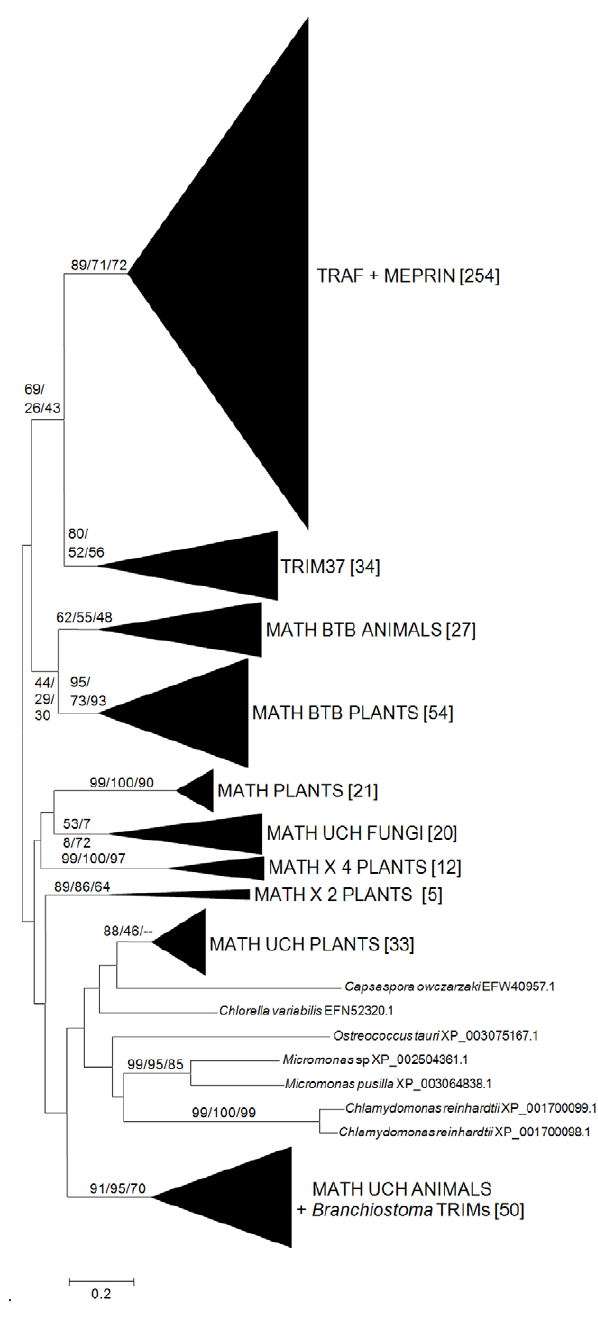
Figure 2. Dendrogram obtained for MATH-containing proteins. Numbers along the branches again refer to NJ/MP/ML bootstrap support. In brackets, the number of proteins within each class. TRAFs and Meprin proteins appeared together in the trees, as did MATH UCH animal proteins (a type of ubiquitin proteases) with a few Branchios- toma Subfamily C TRIMs (discussed in the text). Plant MATH, MATH 6 2 and MATH 6 4 groups correspond to sequences that only have one, two or four MATH domains, respectively. Seven sequences of uncertain classification are indicated in full. See [85] for additional details of all these